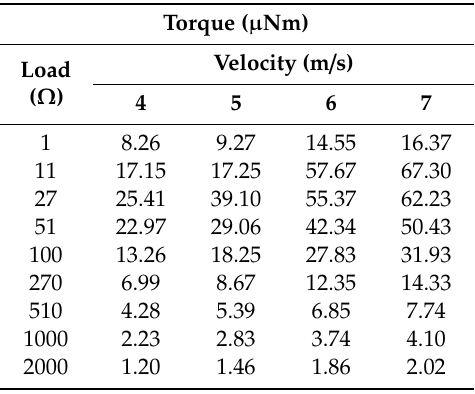
Table 11. Measured values for torque representation.